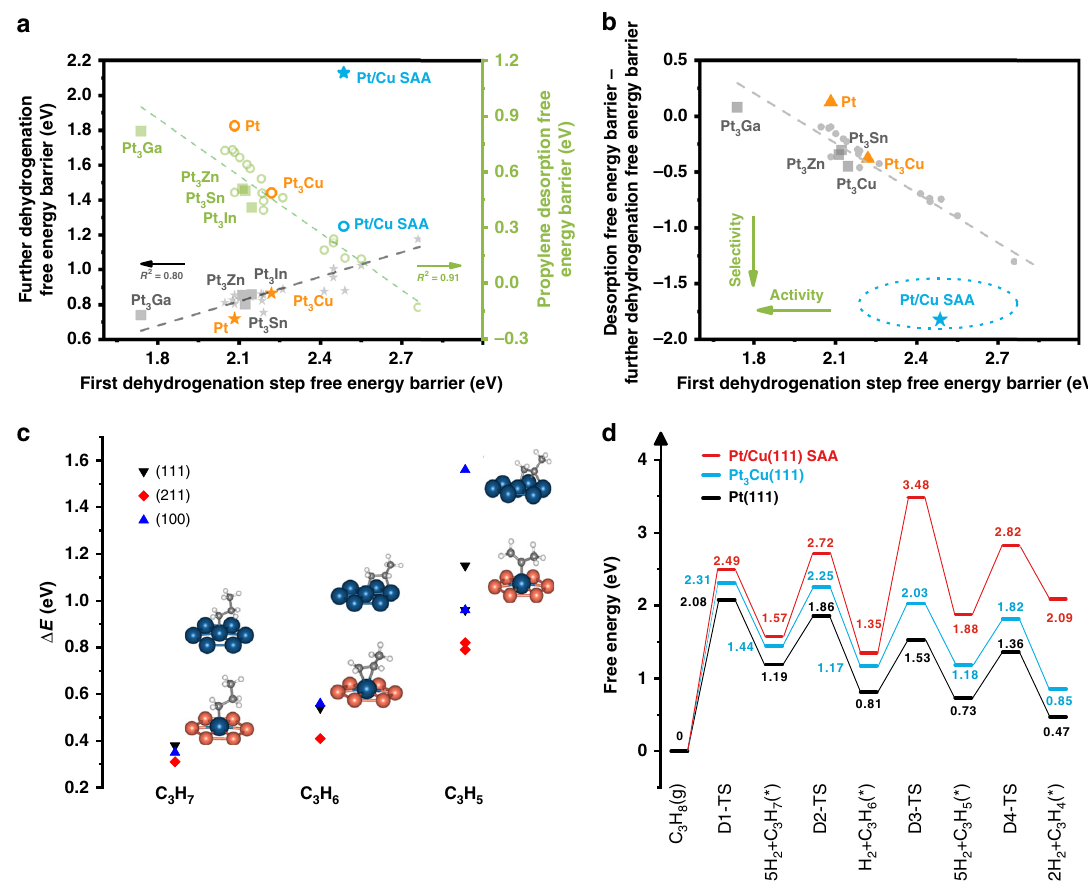
Fig. 1 Pt/Cu SAA breaking the PtM alloy scaling relationship for PDH. a Scaling relationship between fi rst dehydrogenation barrier and propylene desorption barrier/deep dehydrogenation barrier (highest barrier from di- σ propylene to C 3 H 4 ), data for the Pt 3 M alloy systems are obtained from ref. 11 . b Screening of Pt-based bimetallic catalyst for PDH, data for the Pt 3 M alloy systems are obtained from ref. 11 . c Binding energy difference and structures (on (111) surface only) of dehydrogenated intermediates C 3 H x ( x = 7, 6, 5) over pure Pt surfaces and Pt/Cu SAA surfaces. The Δ E is de fi ned as E ads (on Pt/Cu SAA surfaces) − E ads (on Pt surfaces). Color: Pt — blue; Cu — orange; C — gray; H — white. d Energy pro fi les of PDH over Pt/Cu SAA, Pt 3 Cu(111) and